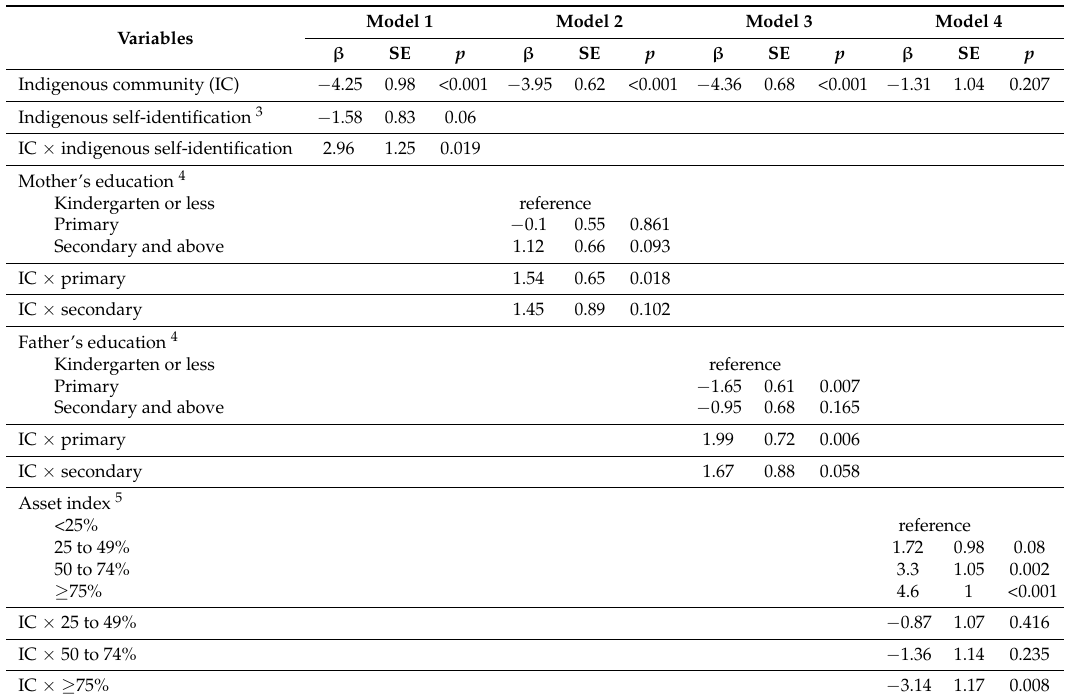
Table 6. Effect modifiers of the OLS model relationship between indigenous community 1 and total HOME 2 Inventory score ( n =